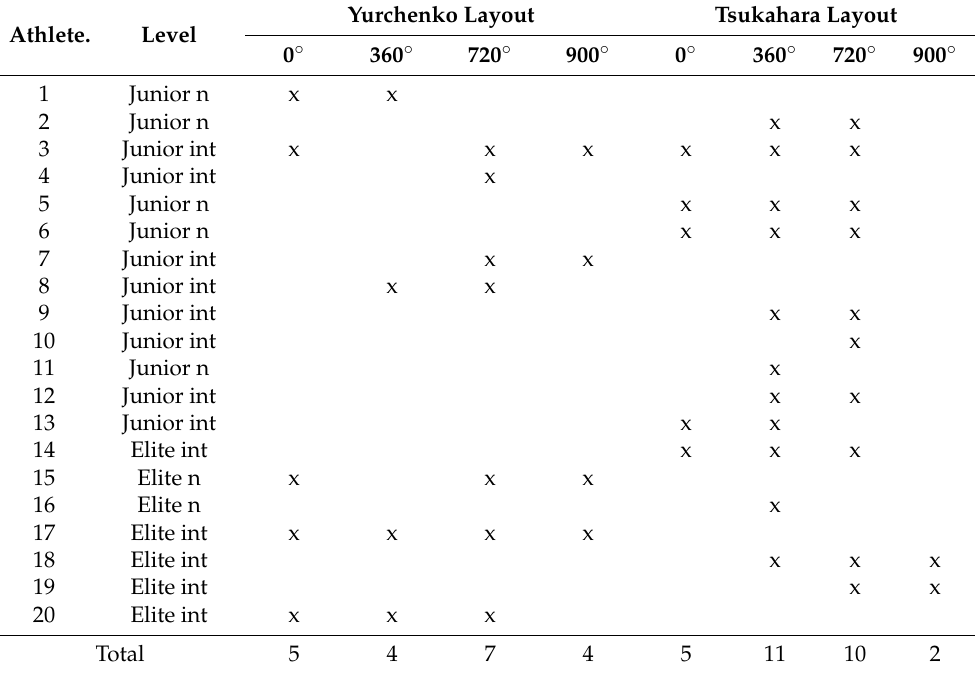
Table 1. Number of the different vaults performed by international (int) and national (n) elite and junior athletes in this study vaults ( ◦ : degrees of rotation around longitudinal axis during the second flight